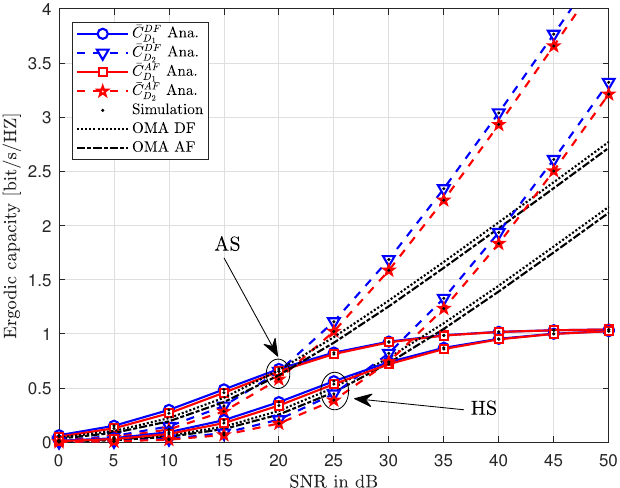
Figure 7. The ergodic capacity versus transmit SNR with different values of R th , where ζ = 0.01, ϑ = 0.1, δ = 0.1, η = 0.9 and m =